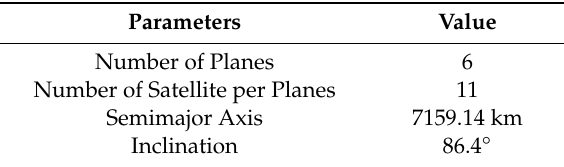
Table 1. The parameters of the satellite